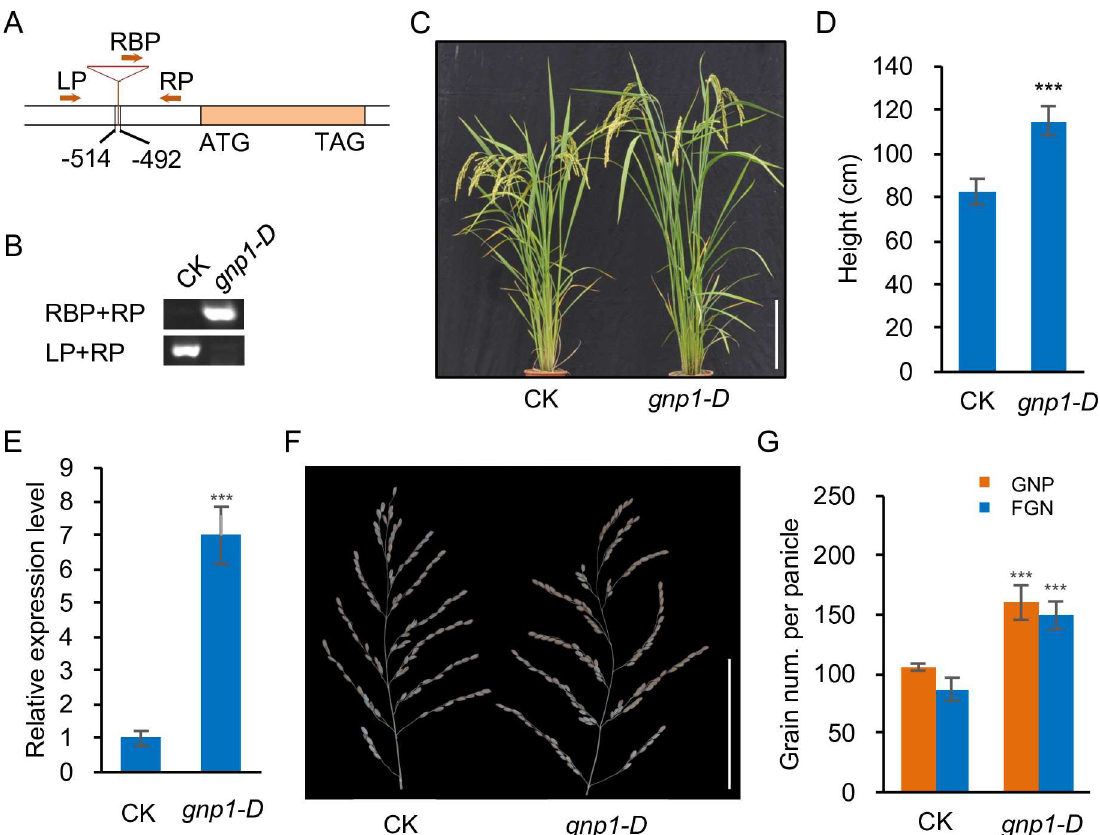
Fig 2. Characterization of the GNP1 T-DNA gain-of-function mutant. (A) Position of T-DNA insertion in the gnp1-D mutant. The primers used for PCR screeningof insertionalmutants are marked with orange arrows. Orange box represents the coding region, inverted triangleindicates T-DNA insertion and negative numbers indicate the detailed insertion position obtained through DNA sequencingrelative to the start codon ATG. (B) PCR screeningof homozygous insertional gnp1-D mutant and the control (CK). (C) Gross morphology of gnp1-D and CK. Scale bar, 20 cm. (D) Comparison of plant height between gnp1-D and CK. Values are means ± s.d. (n = 10 plants). (E) Relativeexpressionlevels of GNP1 in the flag leaves of gnp1-D and CK. Values are means ± s.d. (n = 4). (F) Paniclemorphology of gnp1-D and CK. Scale bar, 10 cm. (G) Comparison of GNP and FGN per panicle between gnp1-D and CK. Values are means ± s.d. (n = 10). Asterisks represent significant difference determinedby Student’s t-test at p -value < 0.001 ( ***